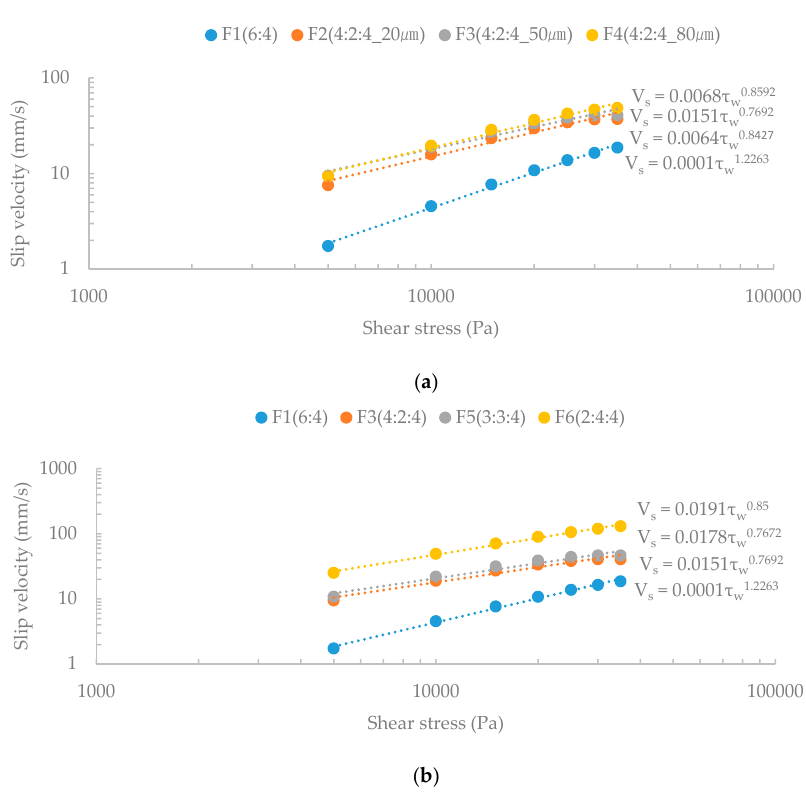
Figure 6. Apparent shear rate vs. 1/ D for F6 which are SUS 316L:space holder:binder = 20:40:40 vol %, polymethyl methacrylate (PMMA) particle size = 50 μ m showing wall slip by using Mooney’s method.